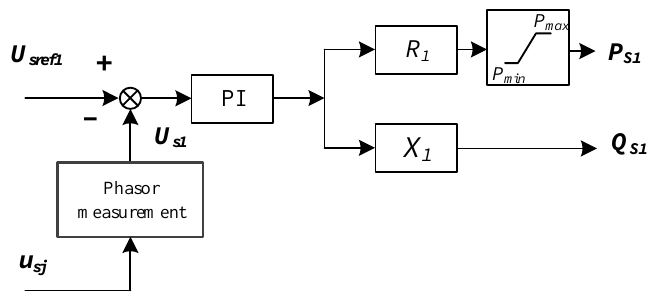
Figure 7. Power delivery based on minimum apparent power control.